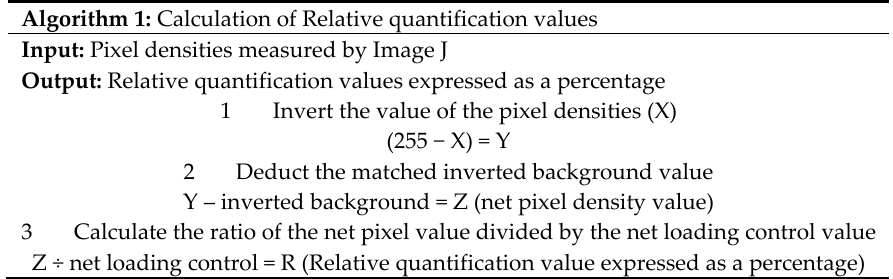
Algorithm 1: Calculation of Relative quantification